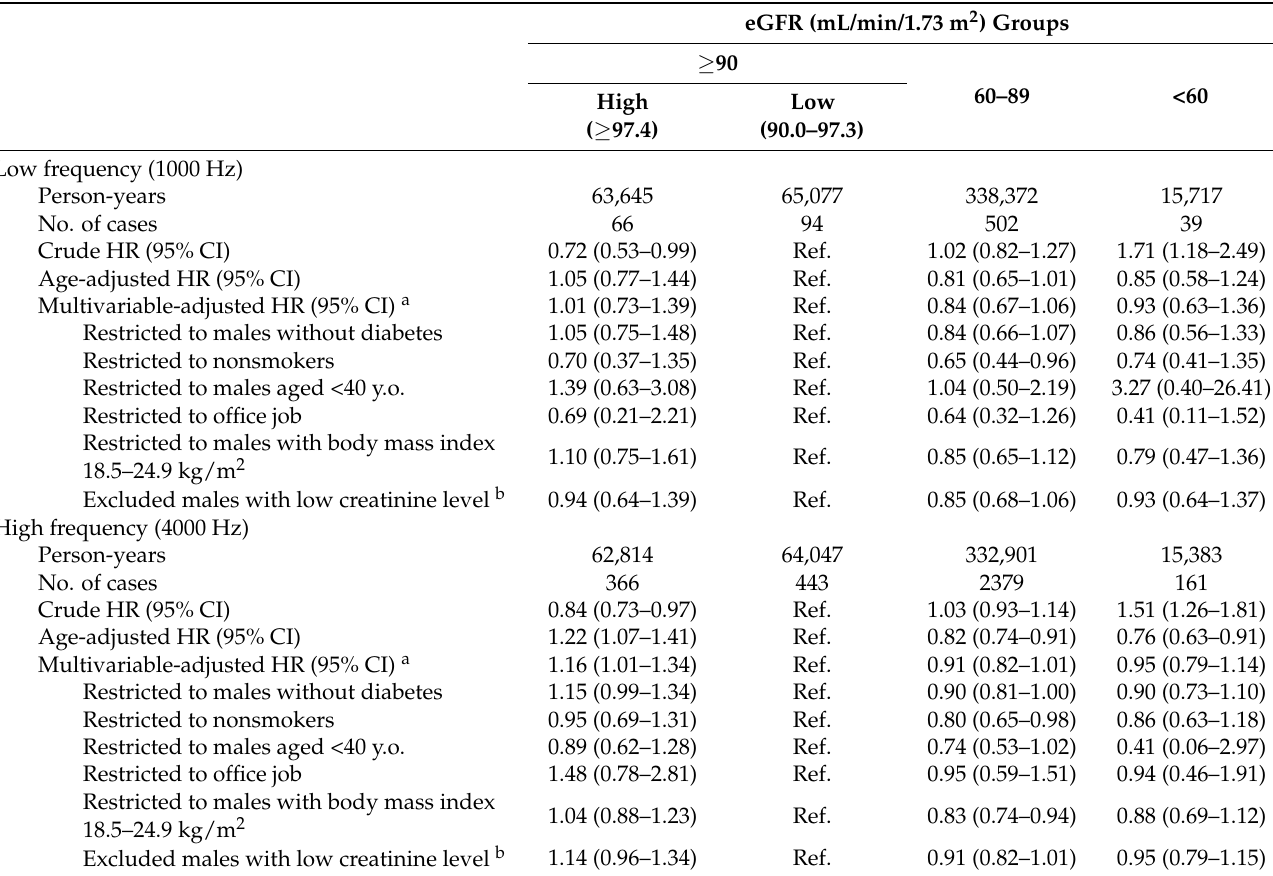
Table 3. Hearing impairment according to estimated glomerular filtration rate groups in male participants.